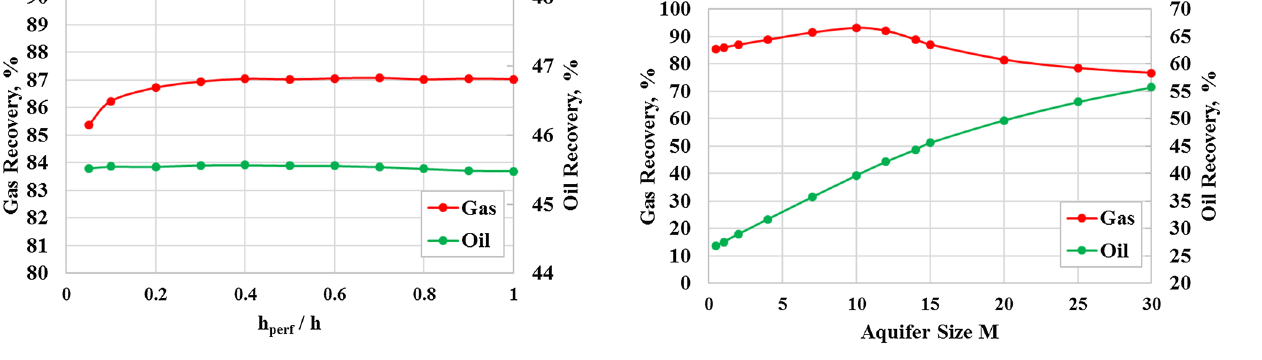
Fig. 27 Gas and oil recoveries for different aquifer sizes